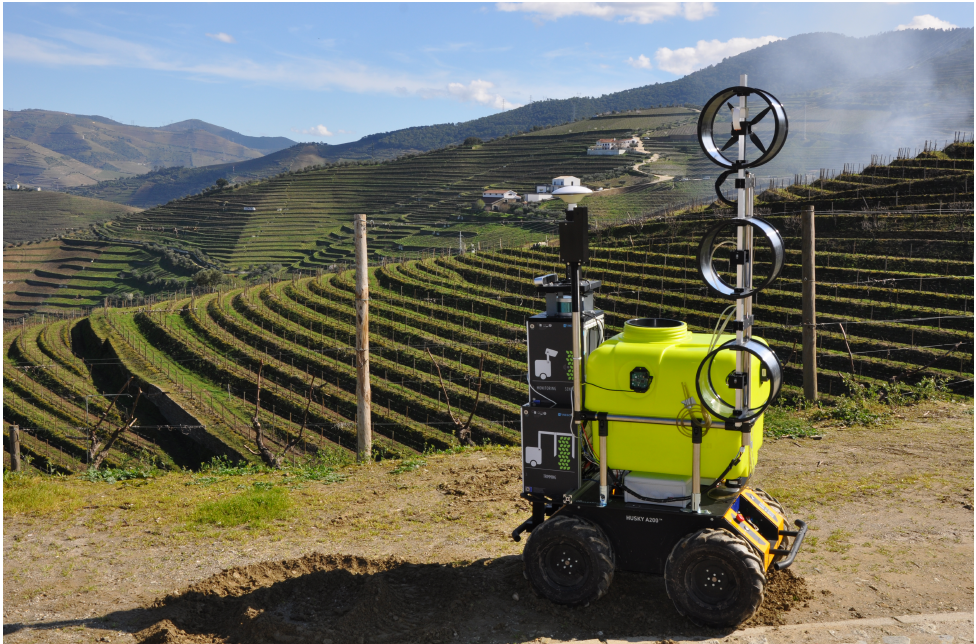
Figure 5. Sprayer assembled on the